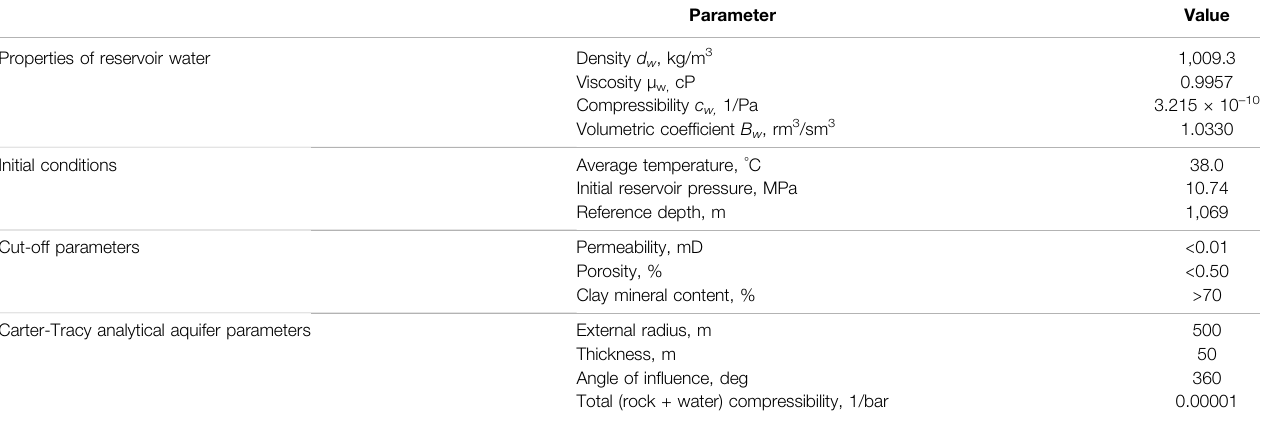
TABLE 3 | Characteristics of reservoir properties and initial conditions of the simulation